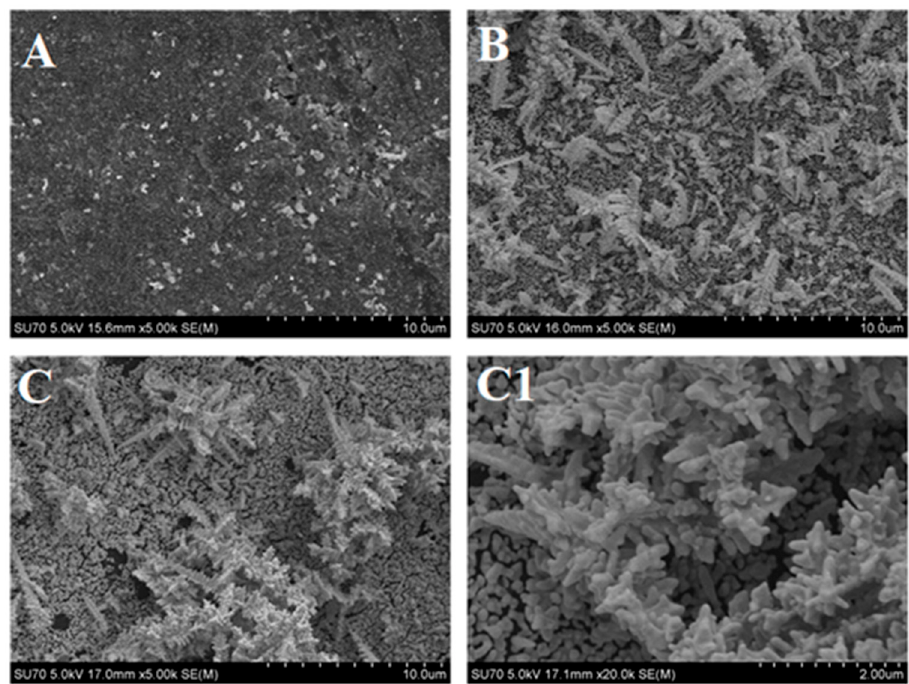
Figure 1. SEM images of the gold nanostructures electrochemically deposited on a graphite rod at constant − 0.2 V potential for 200 s in the solution of 0.1 mol L − 1 KNO 3 containing different concen- trations of HAuCl 4 : ( A ) 0.02, ( B ) 3.0, and ( C ) 6.0 mmol L − 1 (( C1 ) magnified image of picture ( C )).